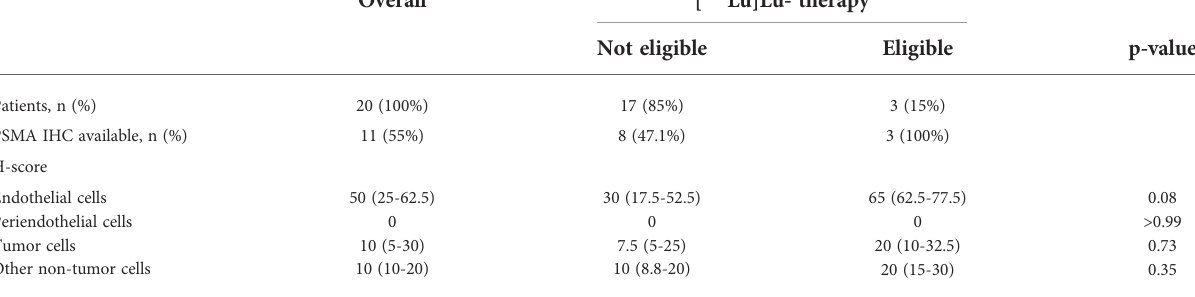
TABLE 3 Immunohistochemical PSMA